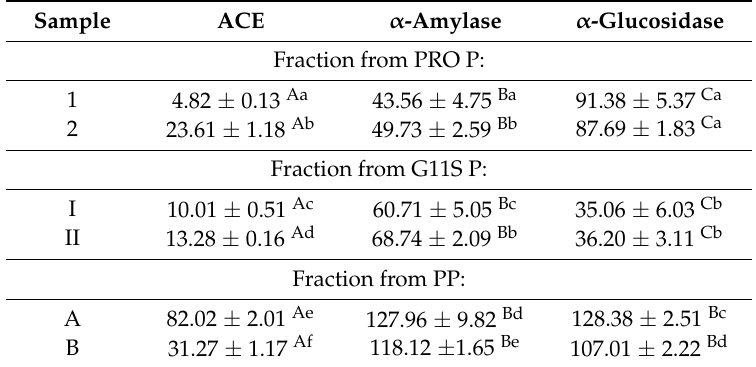
Figure 9. The effect of PH and PP on the cell cycle phases.